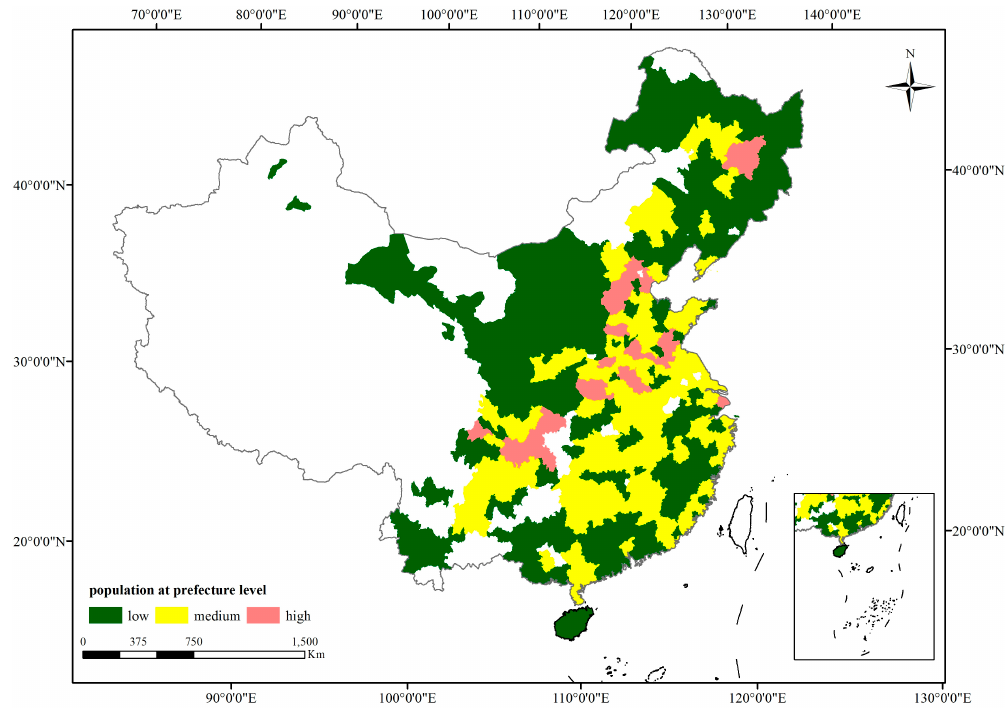
Figure A4. Classifications based on population at prefecture level.